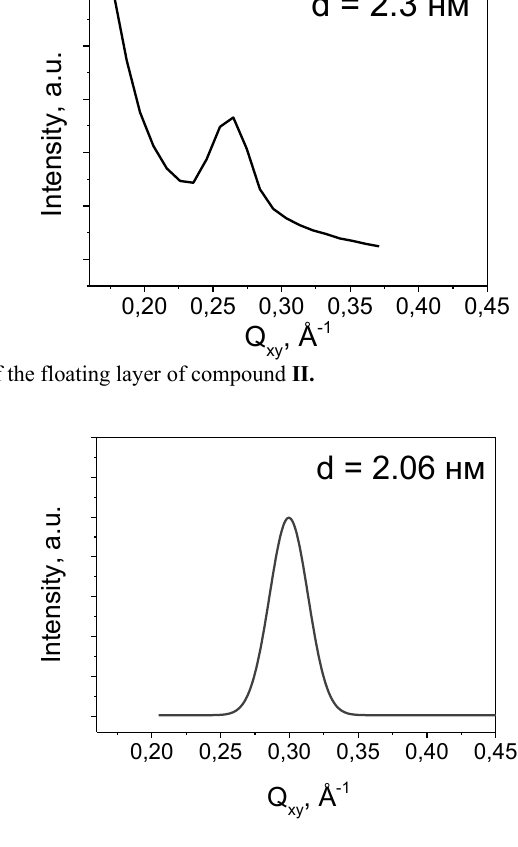
Fig. 5. GID curve of the floating layer of compound